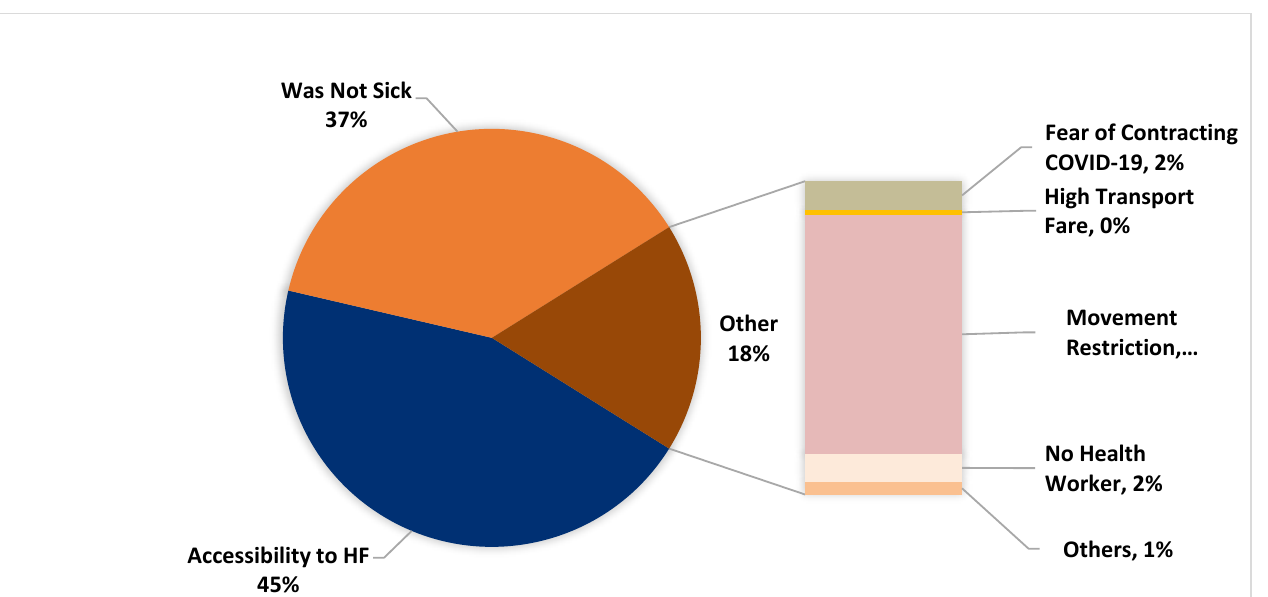
Figure 9. Distribution of access to health facility by the respondents.